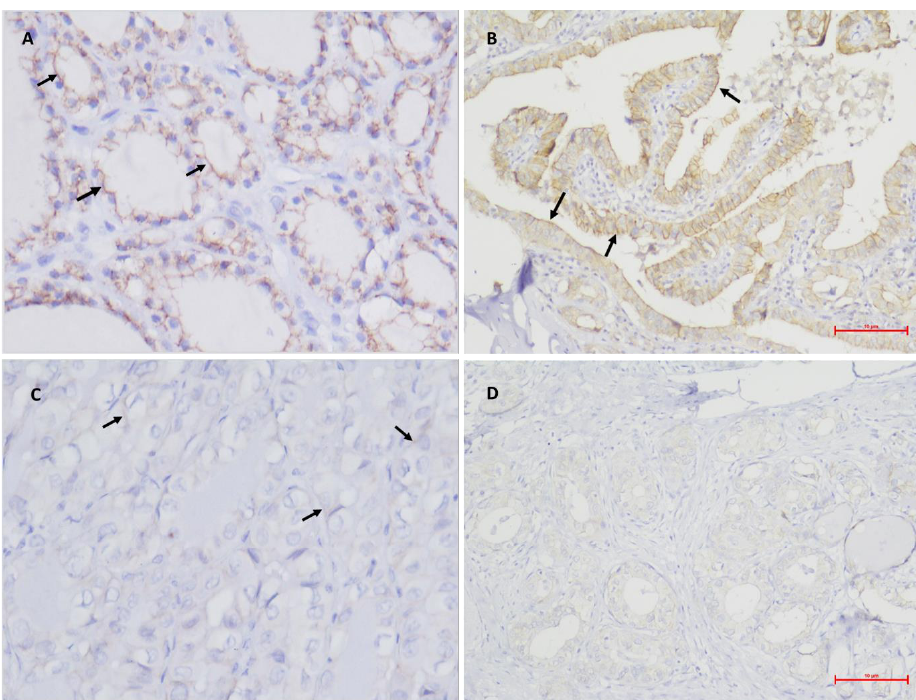
Figure 4. Photomicrographs of the immunohistochemical staining of E-Cadherin (arrows) in the different studied groups, being able to differentiate between all groups. ( A ), benign neoplasm, score 3 (original magnification × 400); ( B ), PTC + 0, score 2 (original magnification × 200); ( C ), PTC + E, score 1 (original magnification × 400); ( D ), PTC + M, score 0 (original magnification × 200).